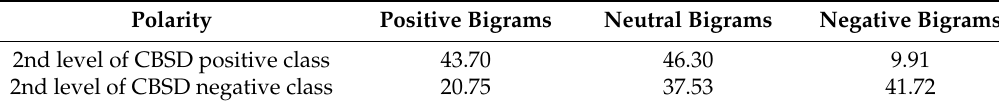
Table 17. Semantic Structure of CBSD